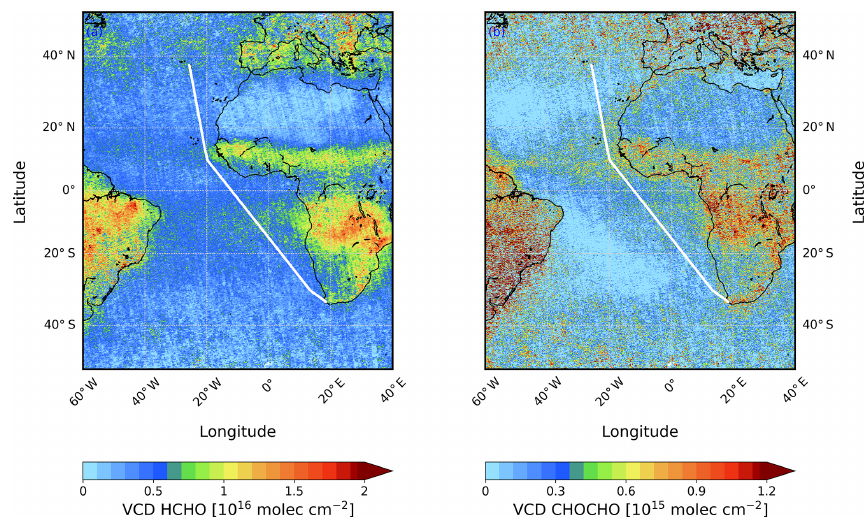
Figure 1. Monthly mean Ozone Monitoring Instrument (OMI) satellite data for (a) HCHO and (b) CHOCHO for October 2016. In white, the track of cruise MSM58/2 is